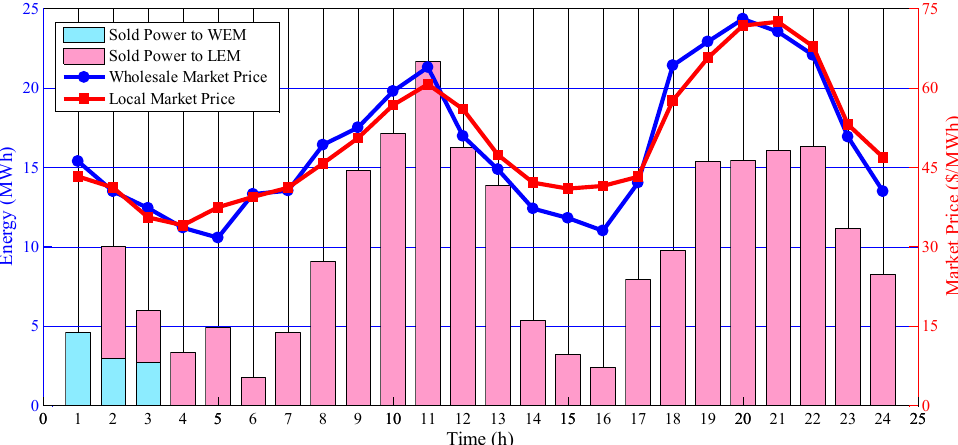
Figure 19. AG’s exchanged energy with markets in the DA stage without considering the competitive environment.